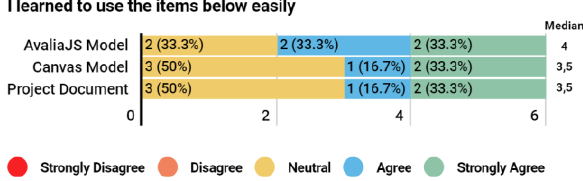
Figure 12. Experts’ answers regarding the ease of use (item 10) of the AvaliaJS model.